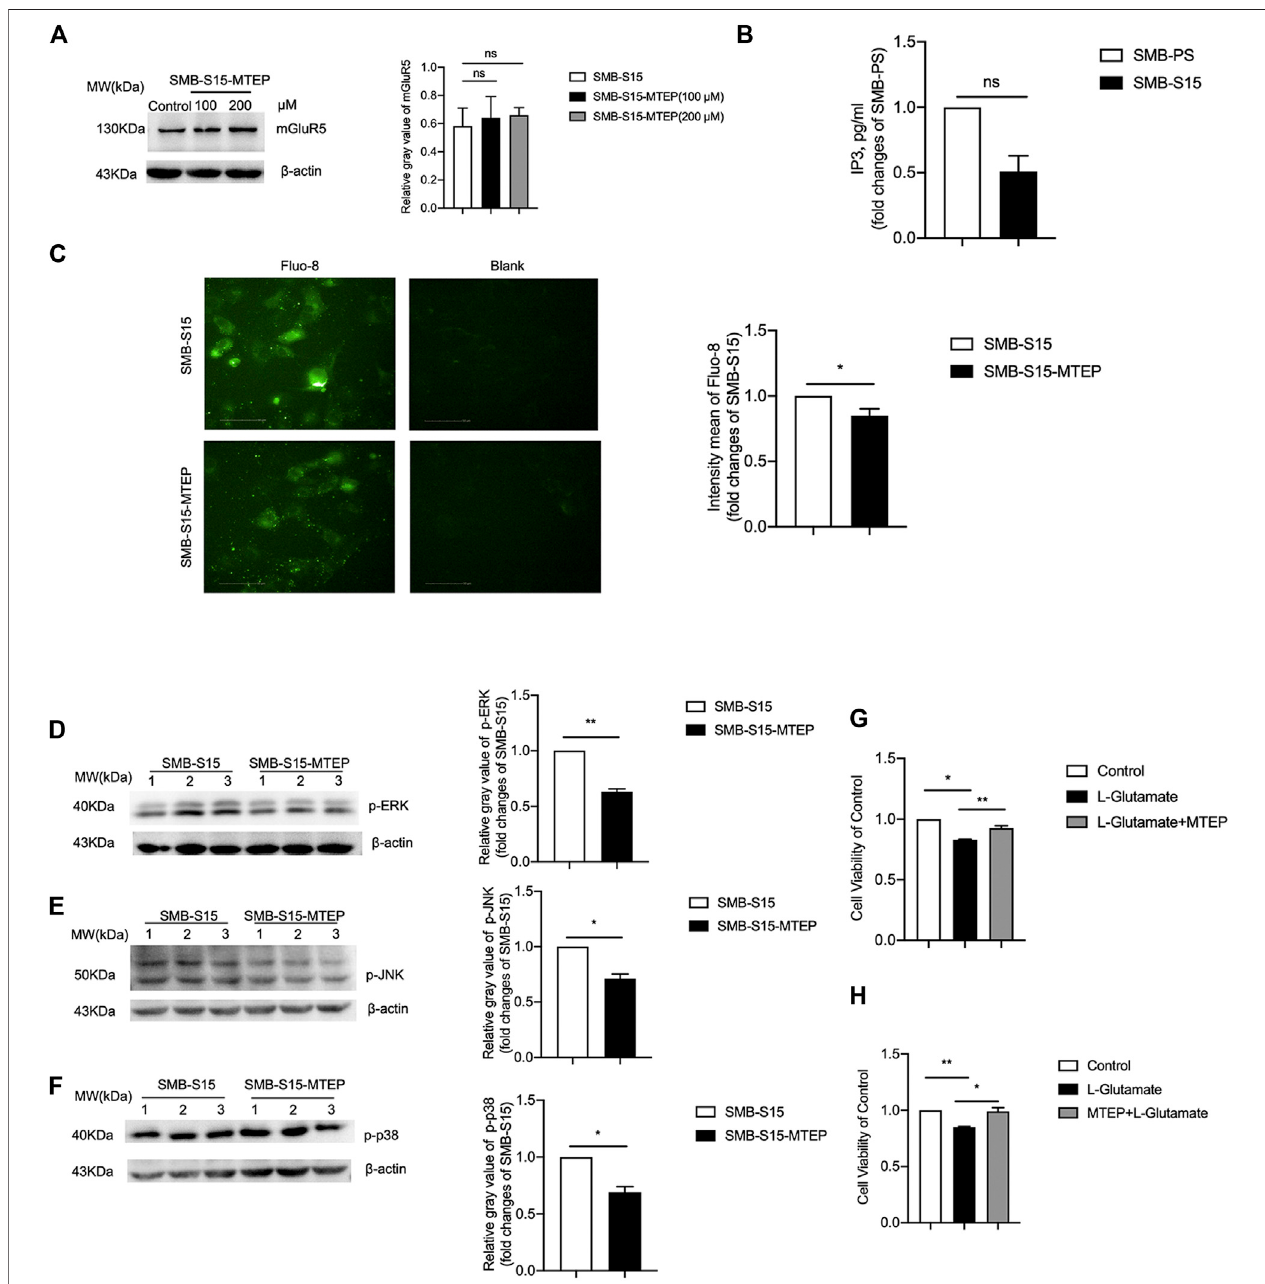
FIGURE5| InhibitionofGPCRs-IP3-IP3R-Ca 2+ andMAPKpathwaysinMTEPtreatedSMB-S15cells. (A) Left : WesternblotforlevelofmGluR5in100and200 μ M of MTEP treated SMB-S15 cells. Right: Densitometric analyses of the average gray values of the signals of the mGluR5 after being equilibrated with that of β -actin. (B) ELISA for the levels of IP3. (C) Immunocytochemical assays for the levels of Ca 2+ concentration. (D-F) Left: Western blots for the levels of p-ERK (D) , p-JNK (E), and p-p38 (F) after MTEP treatment. Relative molecular weights are marked on the left. SMB cell lines are indicated above. (1, 2, 3) indicate the number of replicates. Right: Densitometric analyses of the average gray values of the signals of the target proteins after being equilibrated with that of β -actin. The quantitative results are presentedasmean+SEM.TheIODvaluesofp-p38, p-ERK, andp-JNK inSMB-S15 cellsissetto1and Y -axisrepresentsthefoldchangesinMTEP-treated SMB-S15 versus SMB-S15. (G,H) Cell viability of SMB-S15 cell treated with L-glutamate only or L-glutamate and MTEP alternatively.